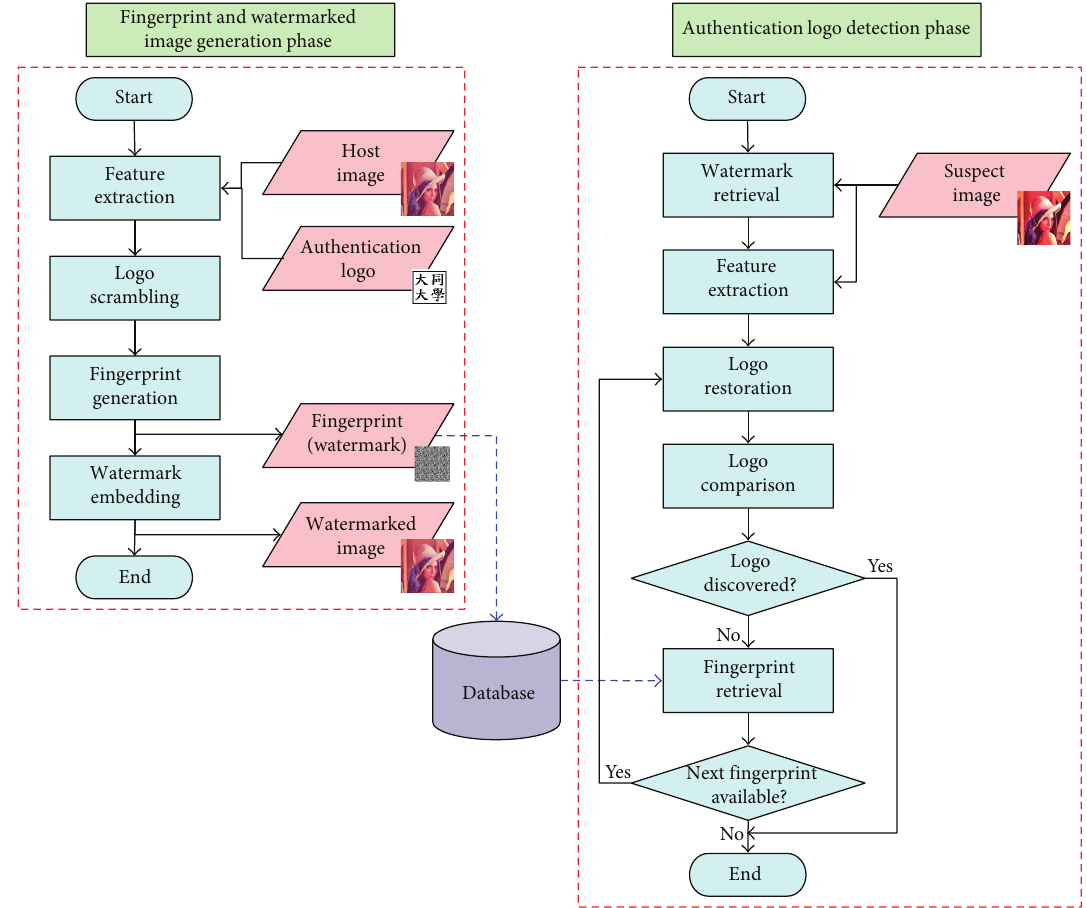
Figure 3: The phases of the proposed